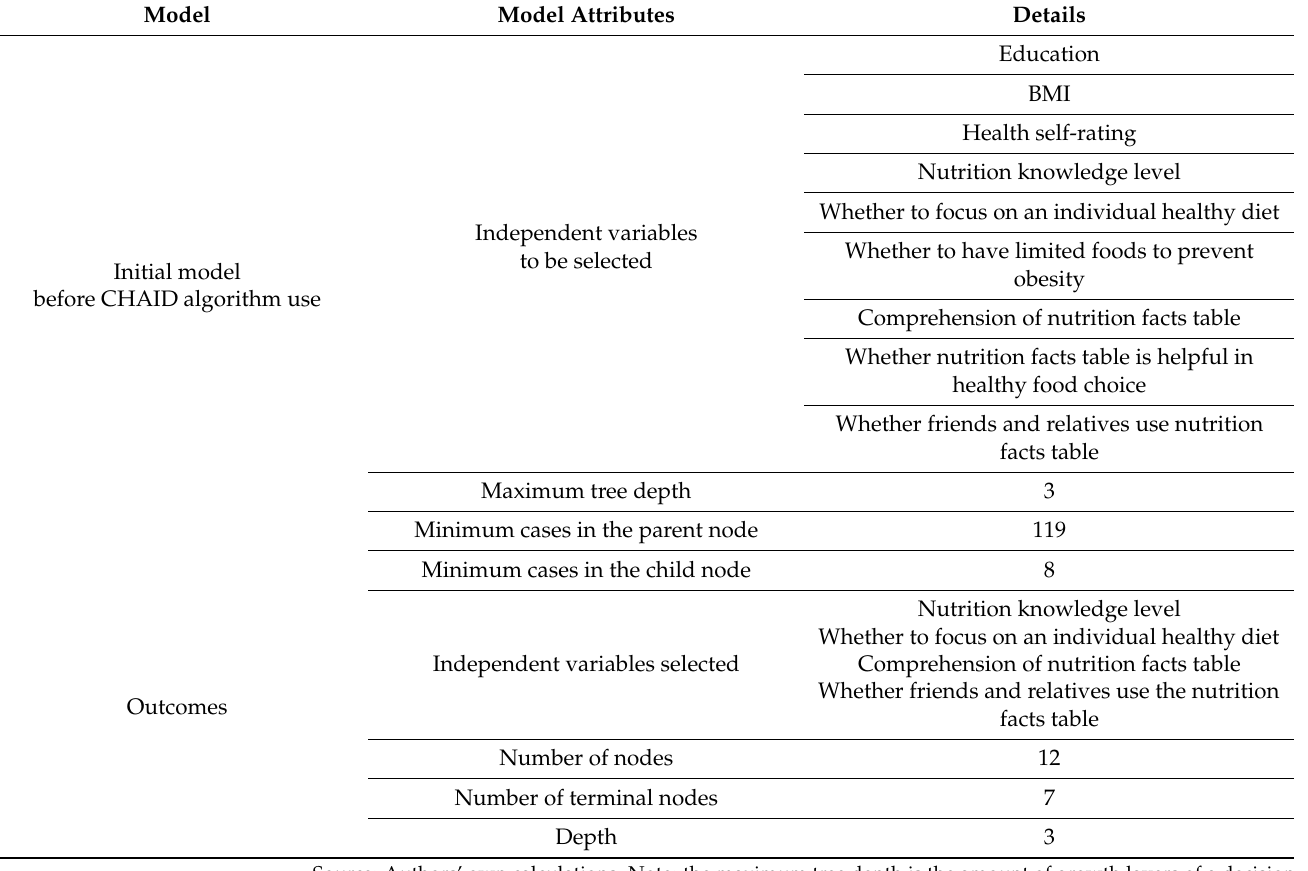
Table 3. Characteristics of the initial model and its outcomes.